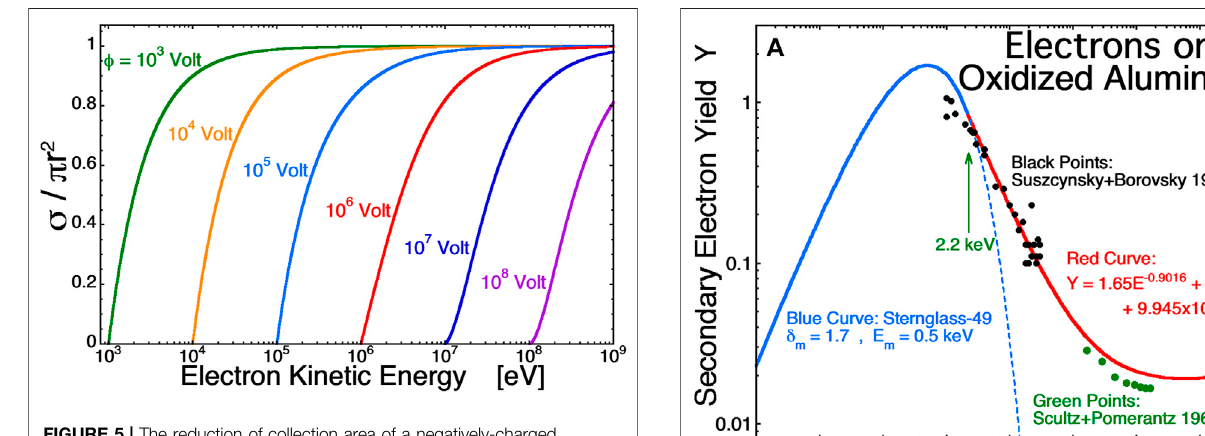
Frontiers in Astronomy and Space Sciences |